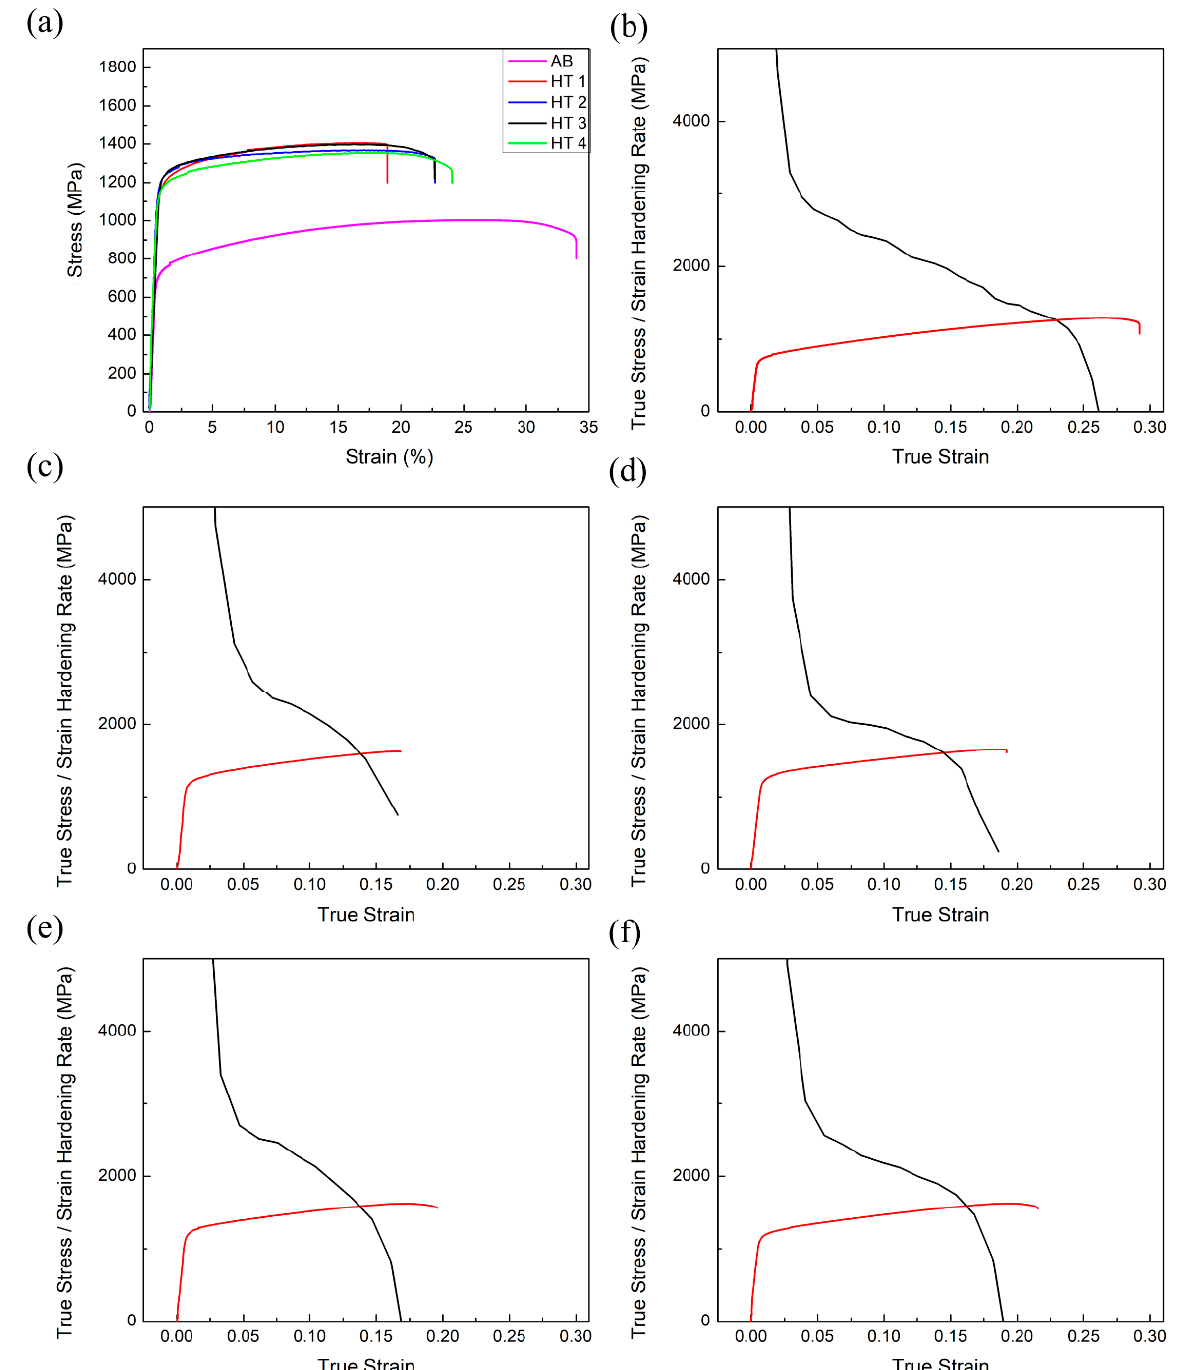
Figure 14. Representative ( a ) engineering stress-strain curves of the IN718 specimens in different conditions, true stress and strain hardening rate vs. true strain of the ( b ) AB, ( c ) HT1, ( d ), HT2, ( e ) HT3, and ( f ) HT4 specimens.